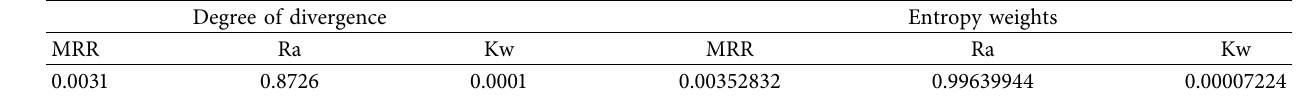
Table 10: Calculated weighted entropy